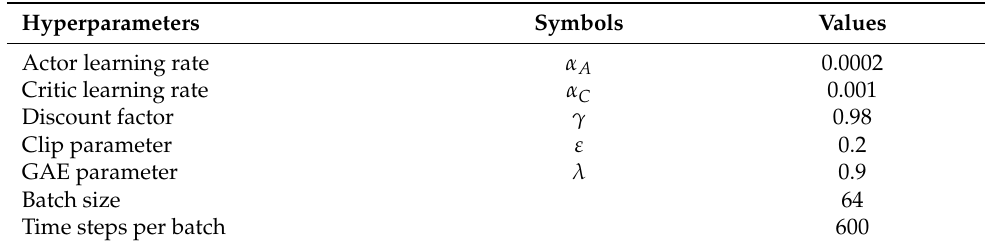
Table 4. Hyperparameters for the proximal policy optimization structure.